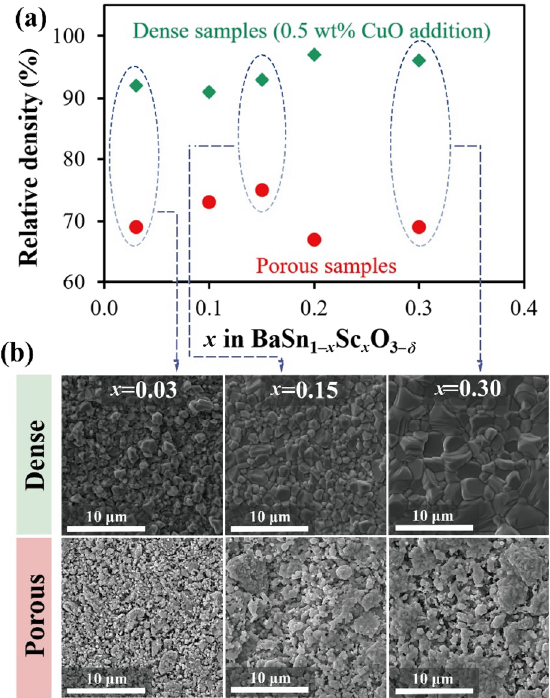
Fig. 9 (a) Relative densities and (b) corresponding SEM images of dense (0.5 wt% CuO) and porous BaSn 1 − x Sc x O 3 − δ ceramic samples for x = 0.03, 0.15, and 0.30.